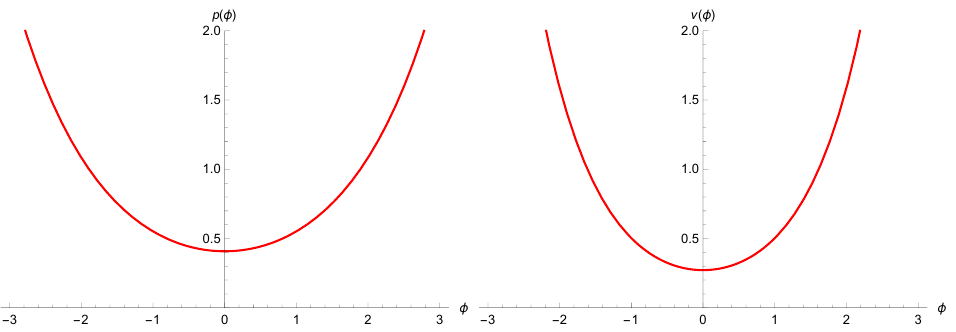
Figure 1. The polymer trajectories of p ( left ) and ν ( right ) as functions of time φ